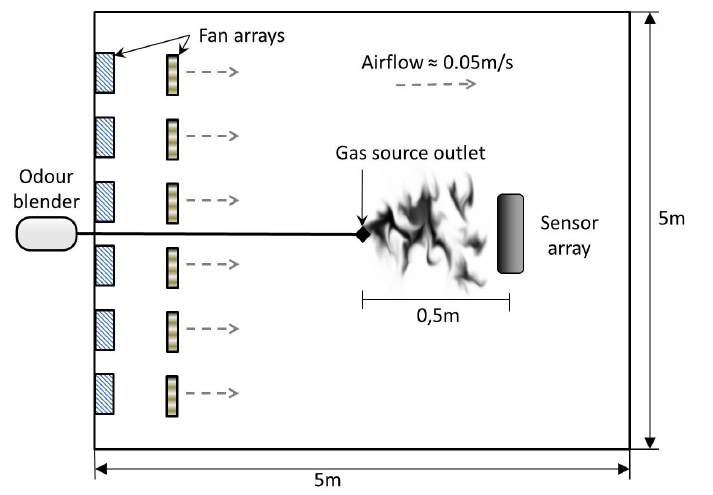
Figure 2. Schematics of the experimental